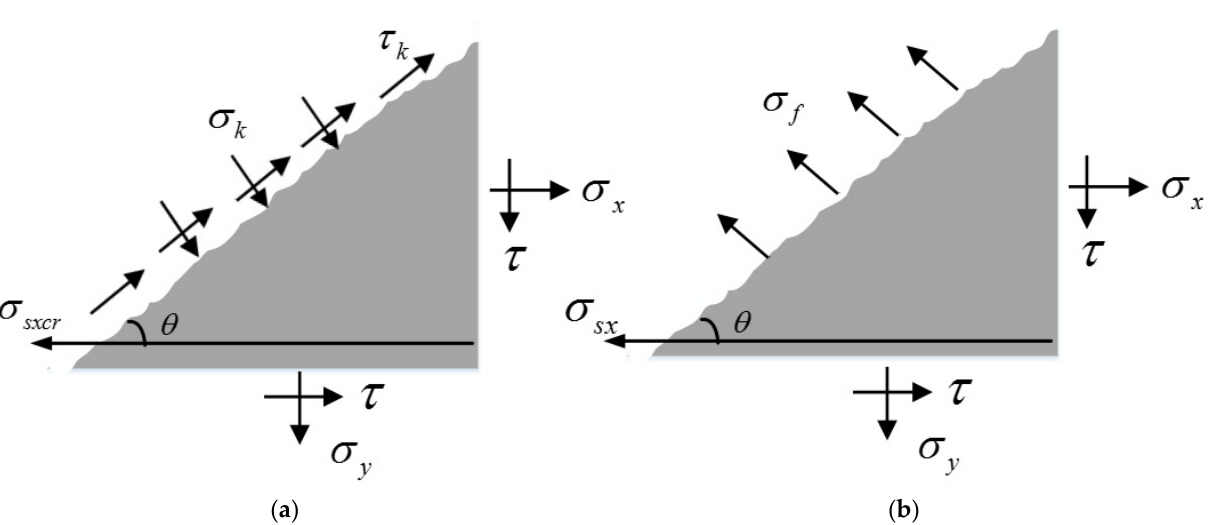
Figure 11. Stress at the crack: ( a ) Crack local stress; ( b ) Average stress.